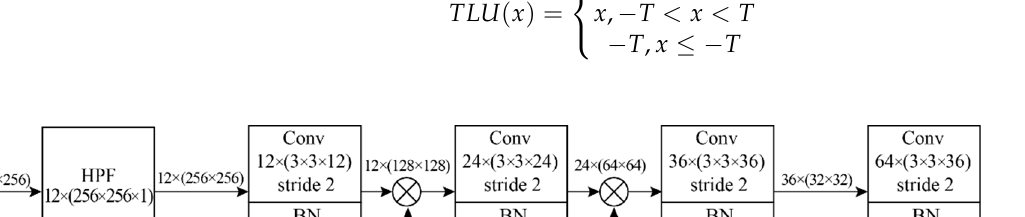
Figure 3. Two methods of combining feature maps.